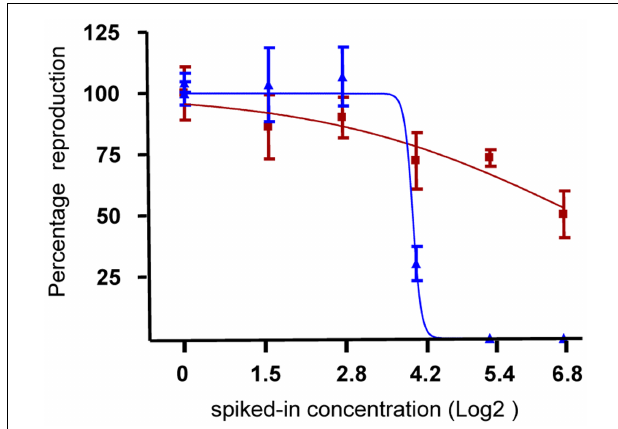
FIGURE 2 | Effect of soil and extract on reproduction of F. candida . Red dots indicate the number of F. candida juveniles in the jars after 28 days exposure to six dilutions of soil samples. Blue dots indicate the number of juveniles retrieved after 28 days exposure to dilutions of extract samples. The lines indicate the dose–response curves derived from a logistic model. x -Axis, Log2 transformed spiked-in concentrations; y -axis, percentage reproduction scaled to the control samples (set at 100%).